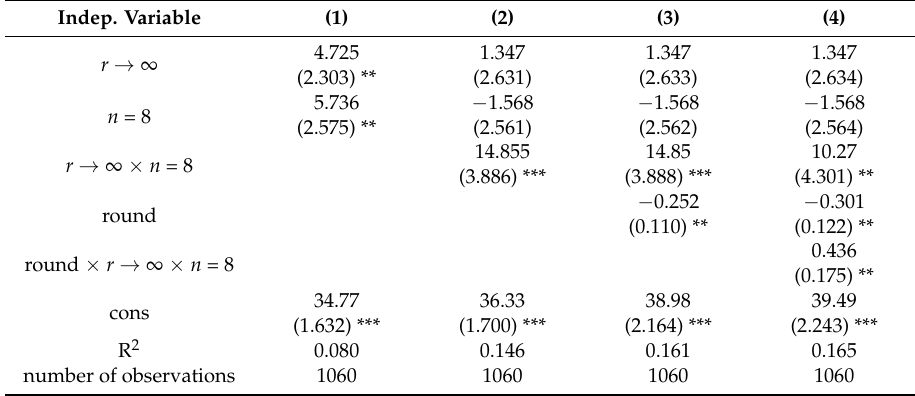
Table 3. Regression of average bets in treatments and round.